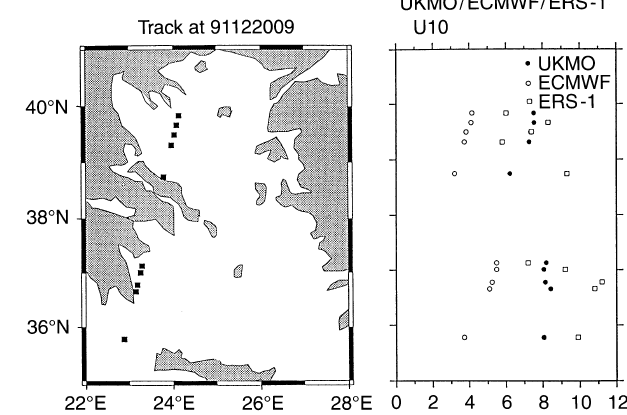
Fig. 14. Comparison of U 10 values between UKMO, ECMWF wind models and ERS-1 wind data (track at 91122009)